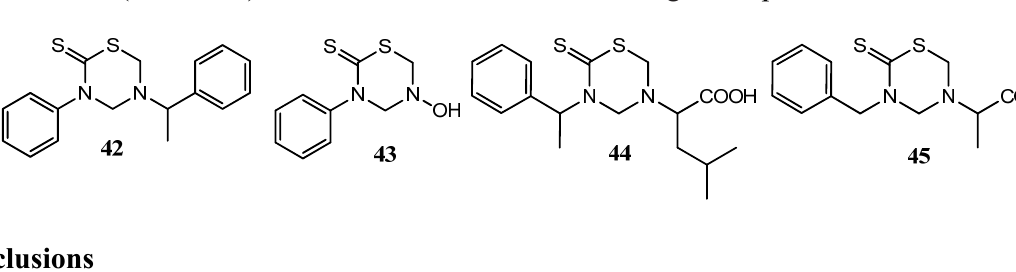
Figure 16. 3-Phenyl-5-(substituted)-THTT derivatives 42 and 43 , and others THTT derivatives ( 44 and 45 ) tested as antibacterial and antifungal